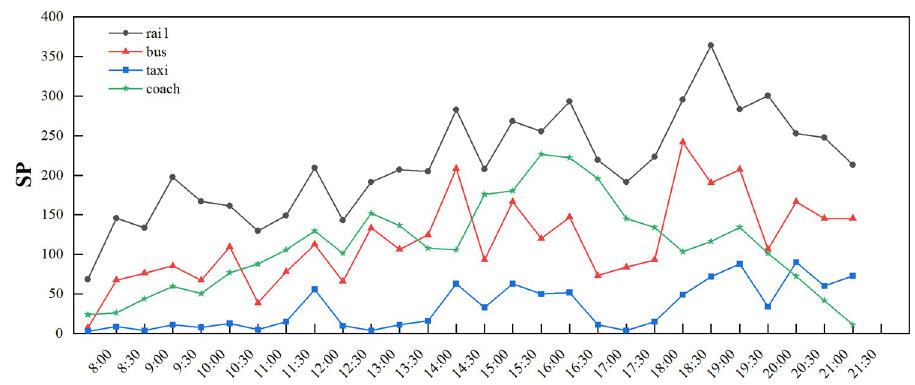
Fig 4. Time-varying chart of the index data of each connection area on September 30 (SP).